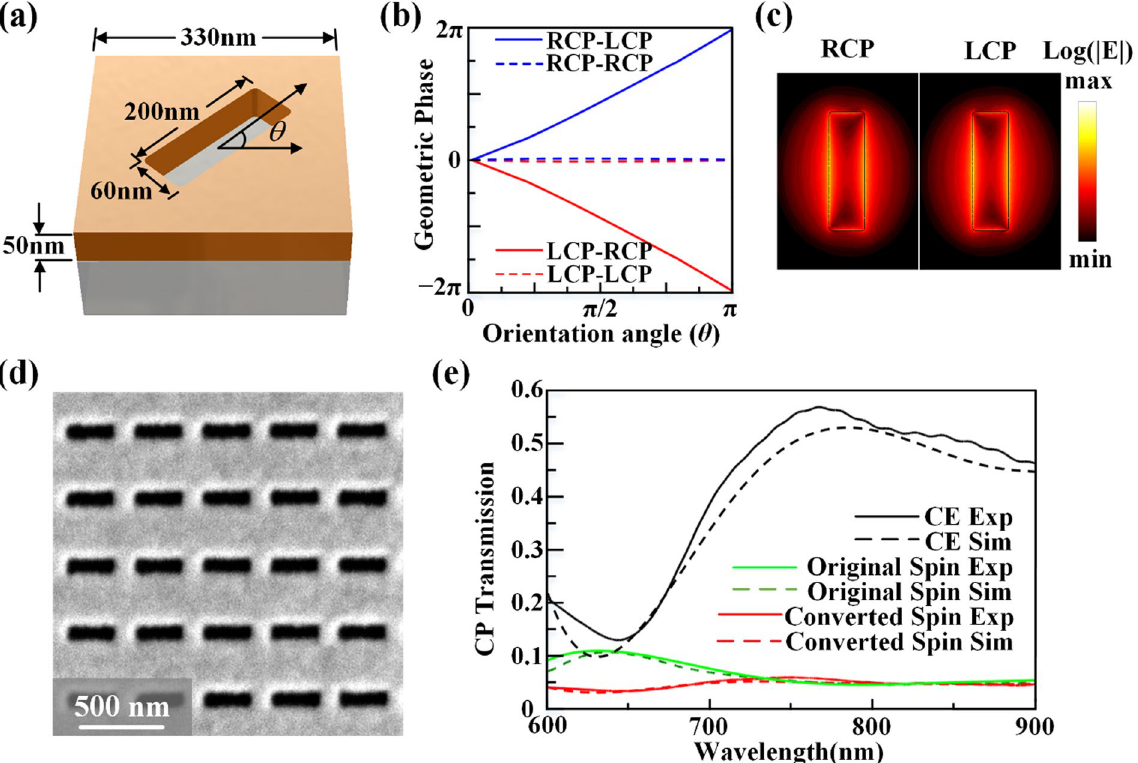
Figure 1. ( a ) Schematic of the unit cell with the nanoslit antenna at orientation angle θ . ( b ) Simulated relationship between the phase shift of the converted polarization and the orientation angle of nanoslit antenna. ( c ) Simulated electric field | E | distributions of nanoslit antenna under circular polarizations at 633 nm. ( d ) A SEM image of the homogeneous nanoslit antenna array. ( e ) Measured and simulated transmission spectra and conversion efficiency spectra under circular polarization